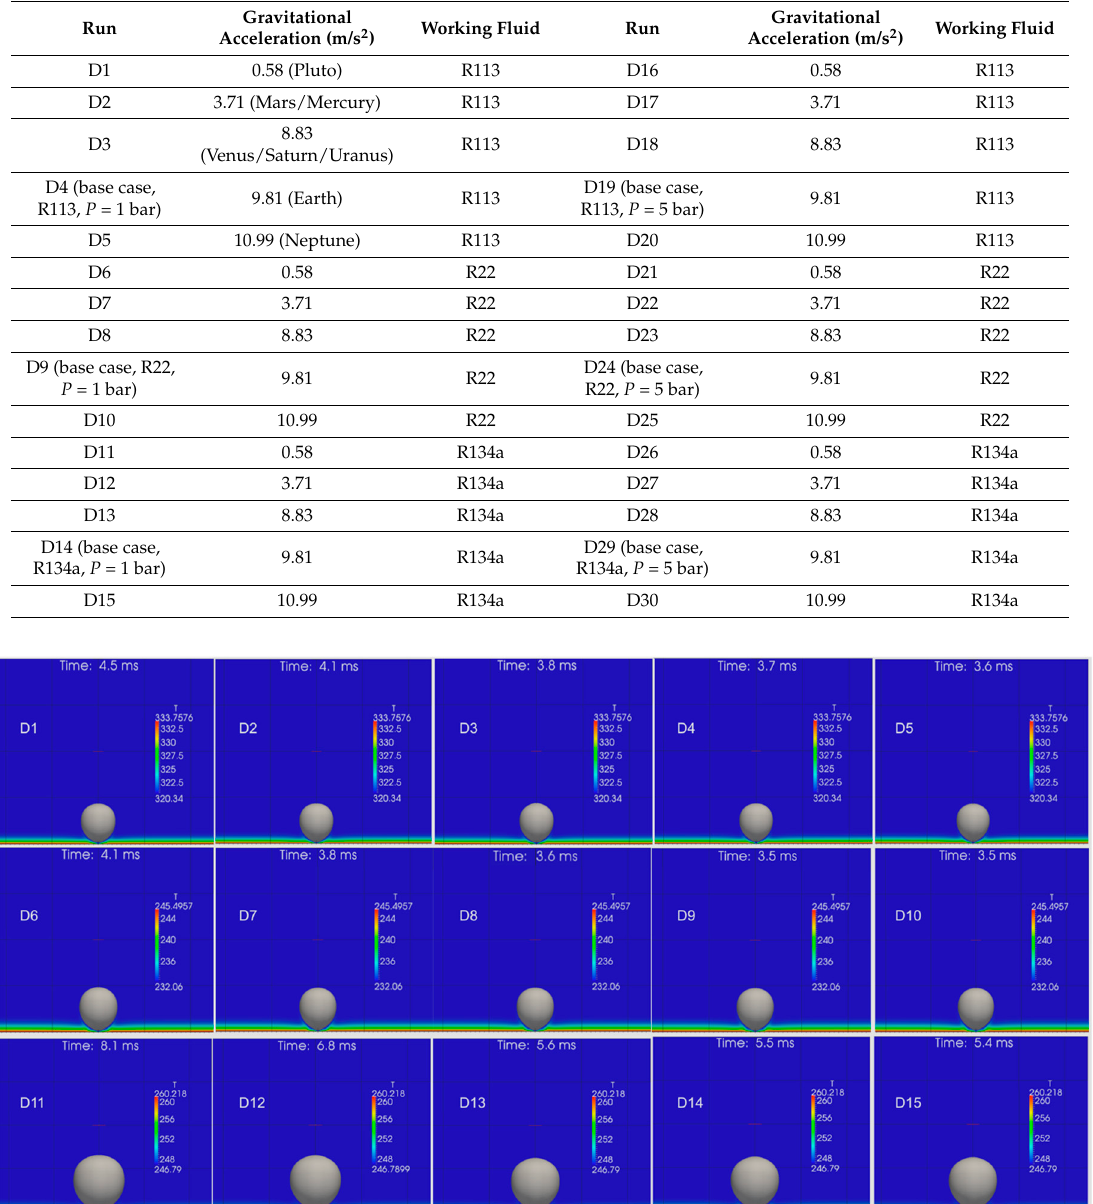
Figure 25. Spatial evolution of generated bubble at the time of detachment for each case of the Series D parametric numerical simulations, with the 5 bar ambient pressure condition.